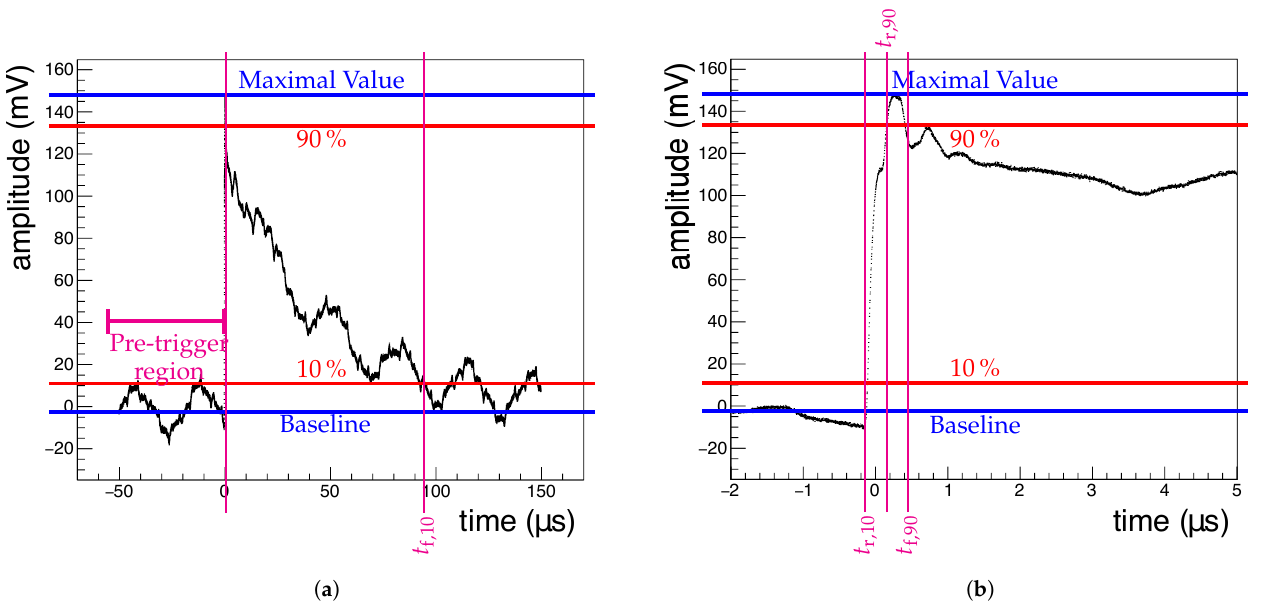
Figure 16. Example for a charge signal, a waveform—( a ) and ( b ) zoom—with some of its defining features indicated. See the text for more explanations. The first vertical line in ( a ) shows the approximate position of all the vertical lines in the zoomed plot in ( b